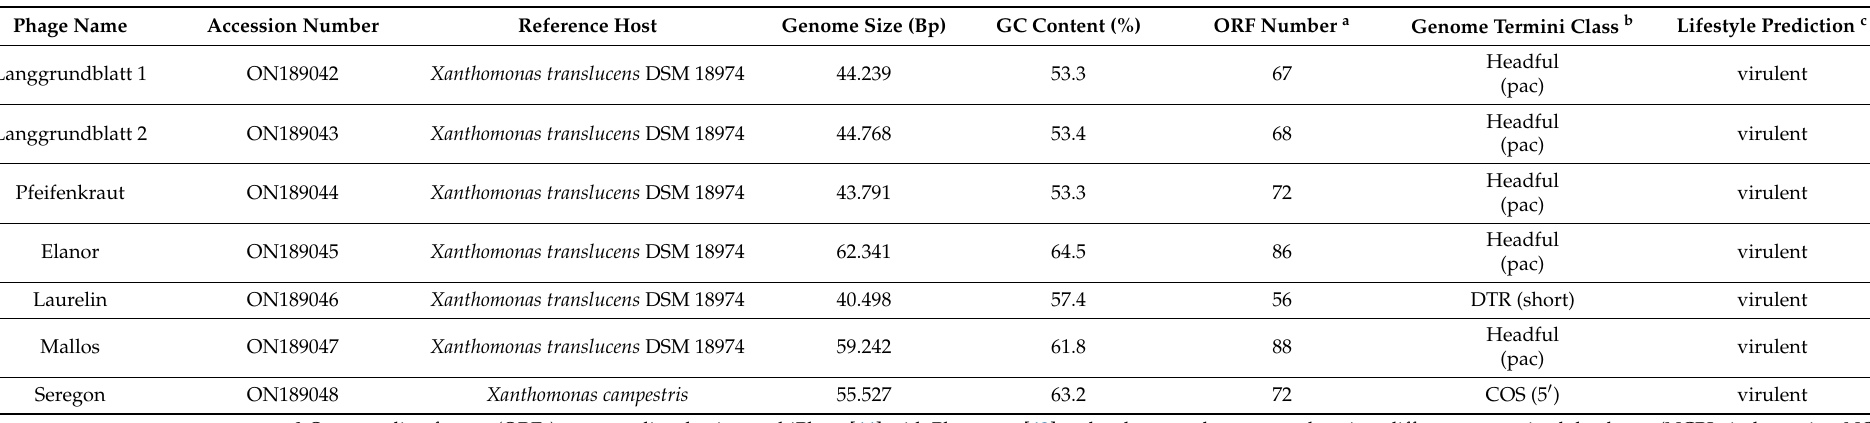
Table 1. Basic genomic features of the seven novel